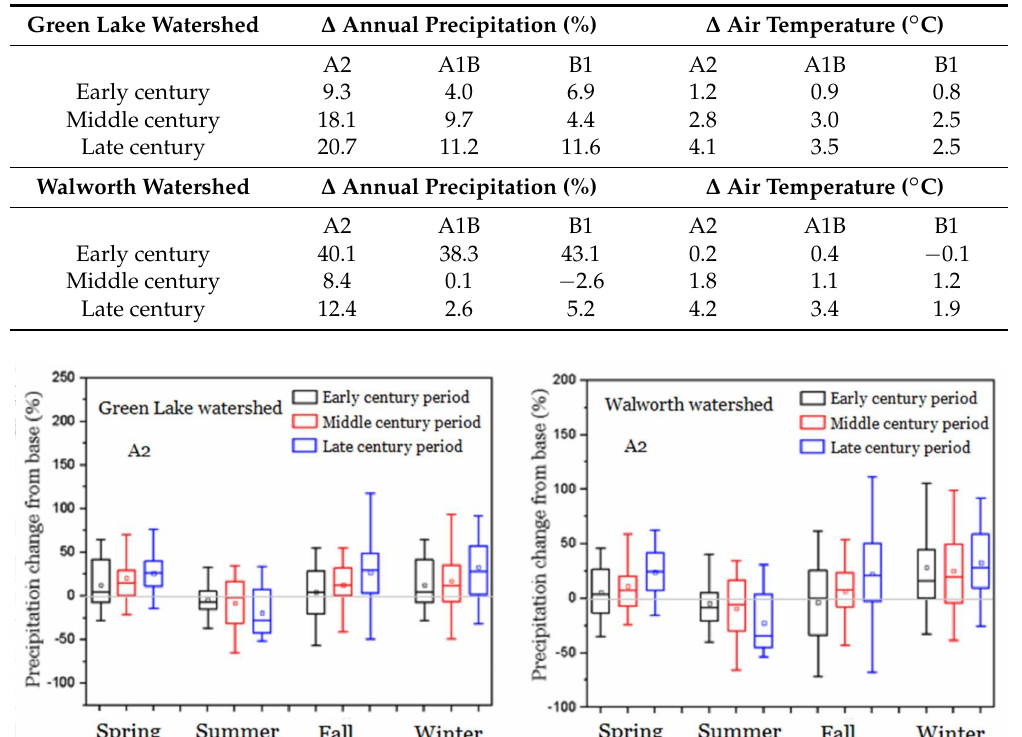
Table 3. Annual average change in precipitation (percent change) and air temperature ( ◦ C) from the base (1996–2012) period for the Green Lake and Walworth watersheds for the three special report emission scenarios (SRES) scenarios: A2, A1B, and B1.